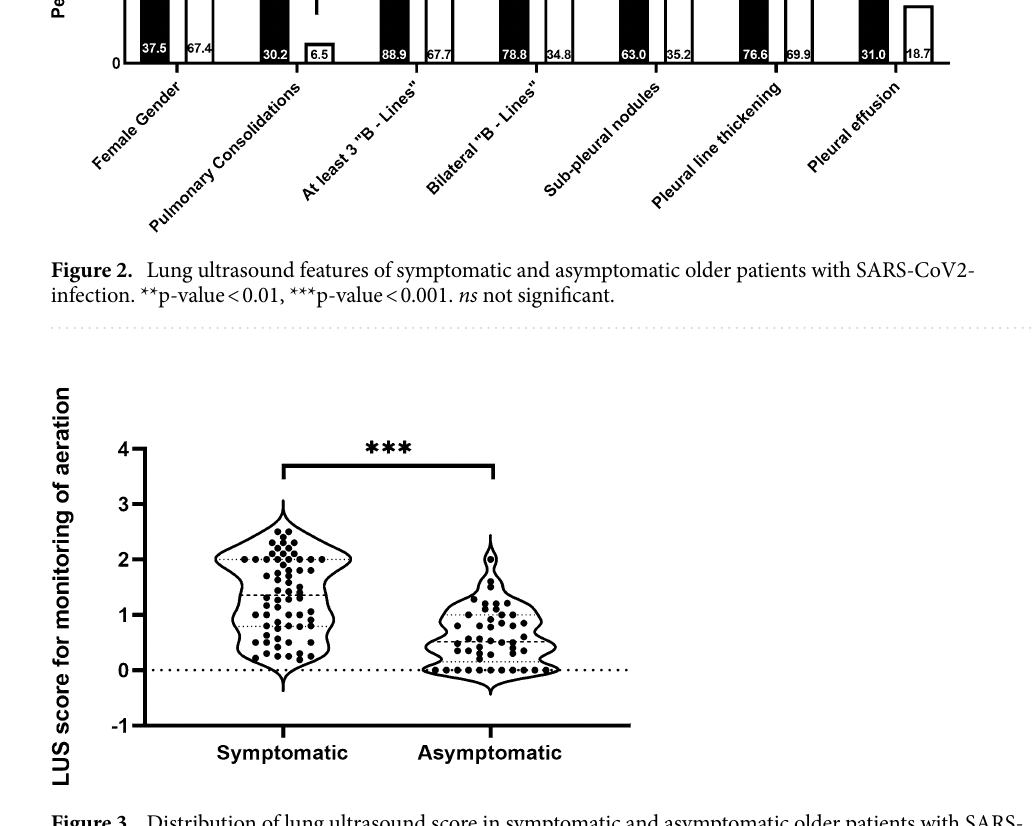
Figure 3. Distribution of lung ultrasound score in symptomatic and asymptomatic older patients with SARS- CoV-2 infection. ***p-value <